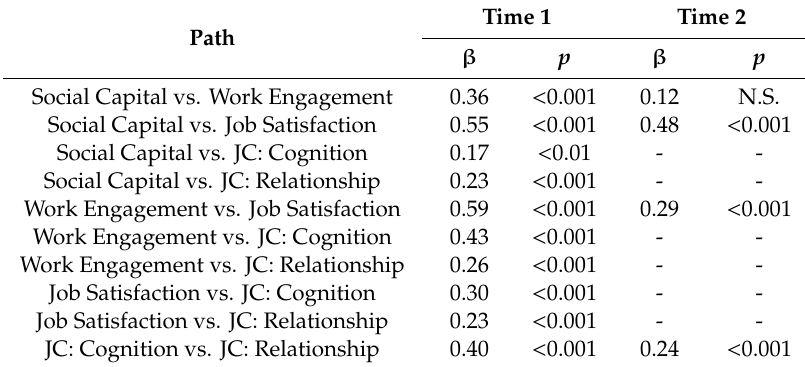
Table 3. Standardized estimates and p -values for concurrent variance in the mediation model.